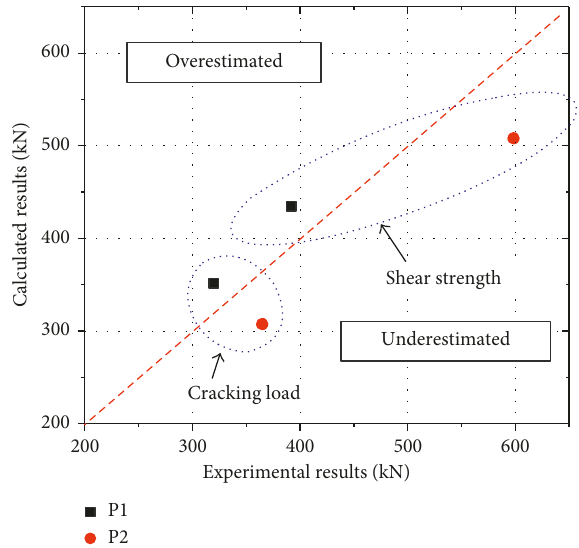
Figure 20: Comparison of experimental and calculated